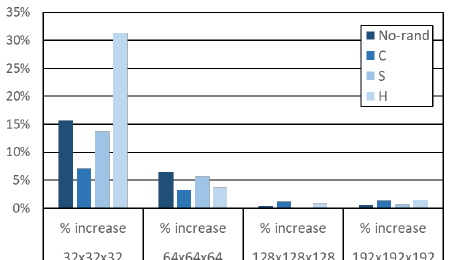
Figure 11. Relative increase of the pWCET estimate at an exceedance probability of 10 − 6 w.r.t. maximum execution times (MET) for the different